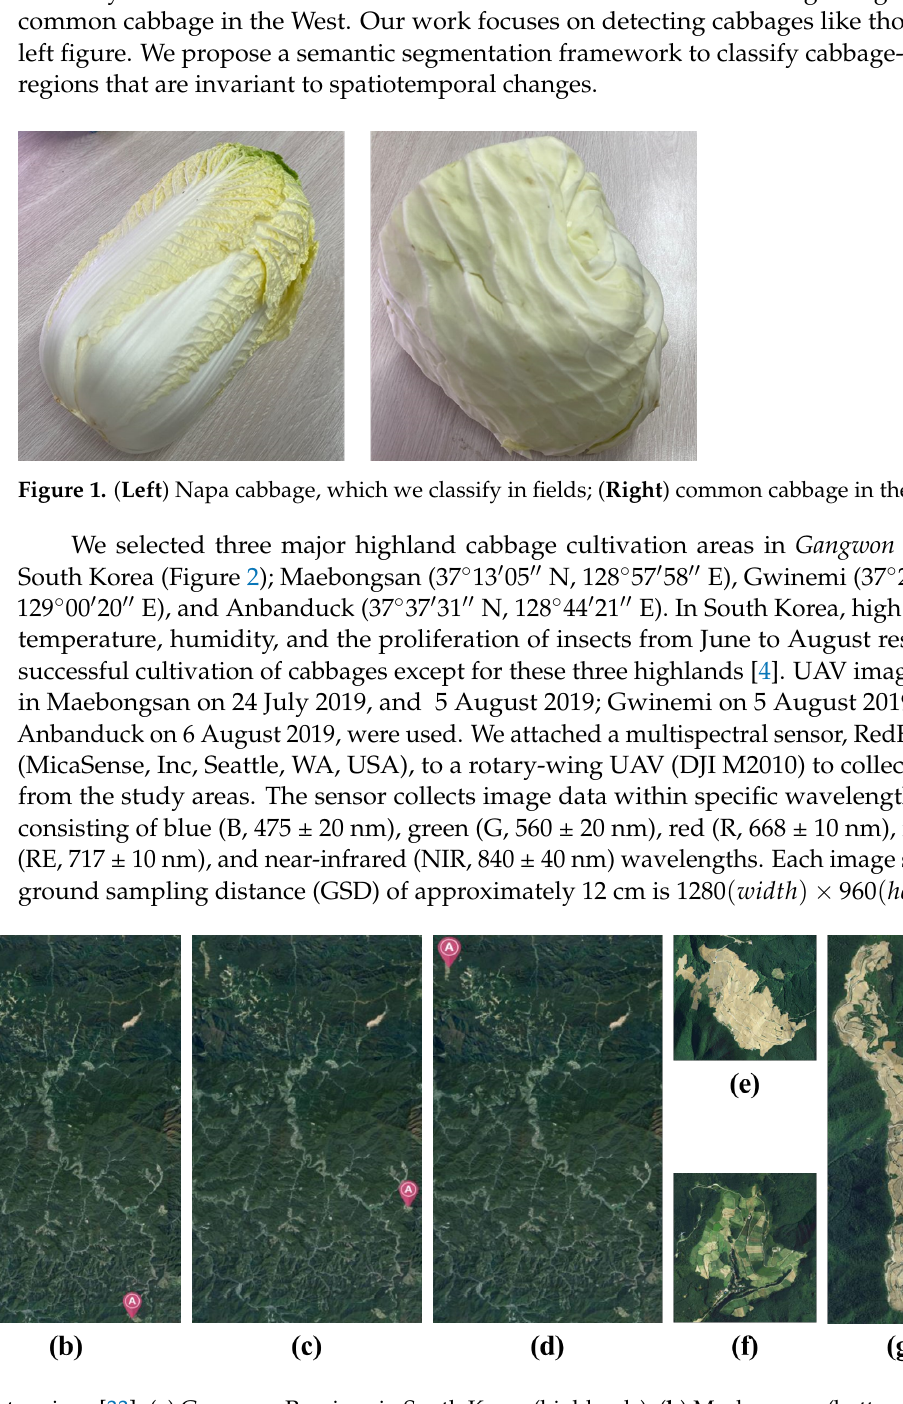
Figure 2. Location of target regions [33]. ( a ) Gangwon Province in South Korea (highlands); ( b ) Maebongsan (bottom red point); ( c ) Gwinemi (middle red point); ( d ) Anbanduck (top red point); ( e ) Maebongsan; ( f ) Gwinemi; and ( g )